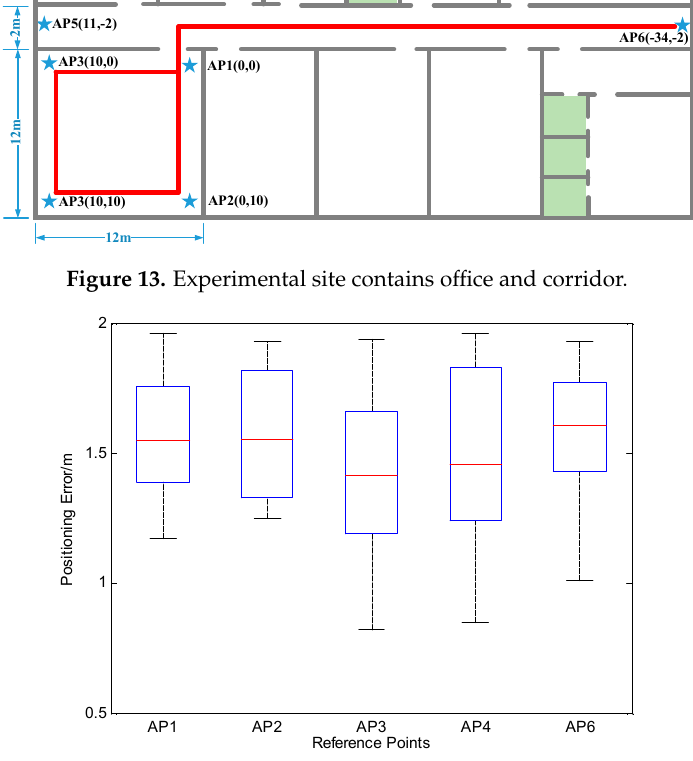
Figure 13. Experimental site contains office and corridor.